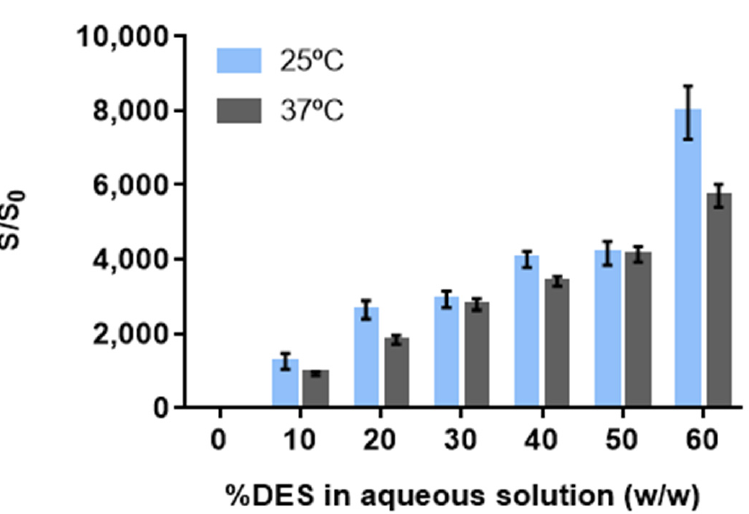
Figure 2. Solubility enhancements for ibuprofen in arginine:glycerol aqueous solutions achieved at both room and body temperatures. The results are expressed as the mean ± SD of three independent experiments.